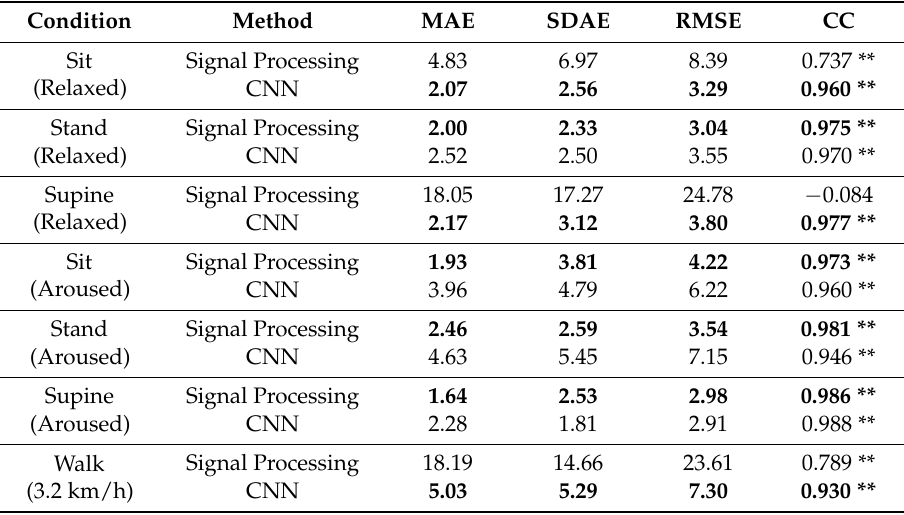
Table 6. Estimation of heart rate in 12 measurement conditions by signal processing and